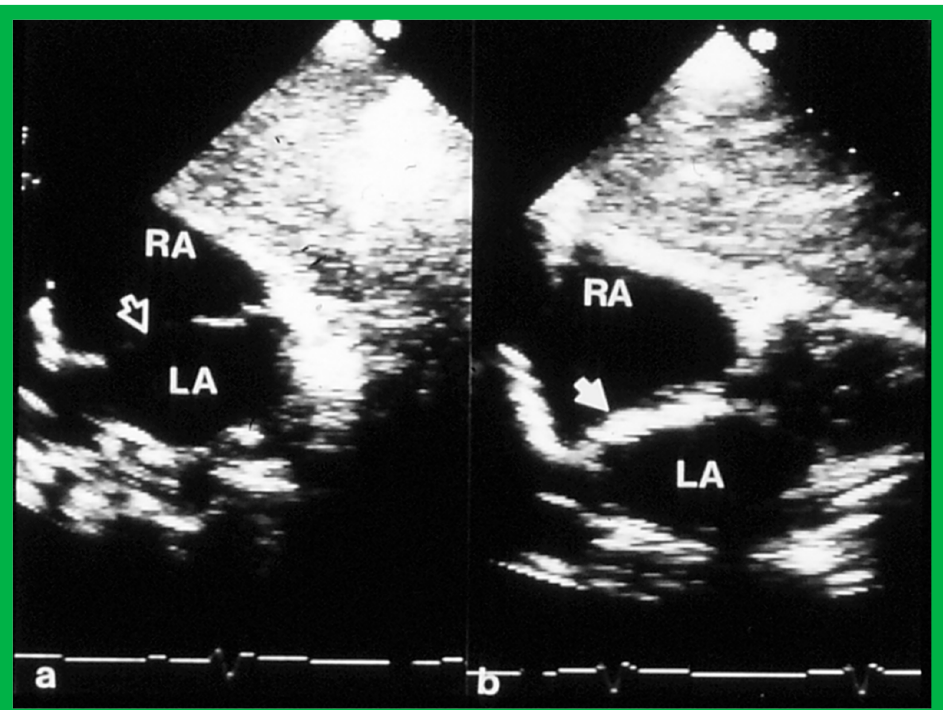
Figure 39. Echocardiographic images from subcostal projections demonstrating an atrial septal defect (ASD) (unfilled arrow) with adequate septal margins before ( a ) and shortly after ( b ) device (filled arrow) deployment. Residual shunt was not seen by color flow Doppler (not shown). LA, left atrium; RA, right atrium. Replicated from Reference [62].